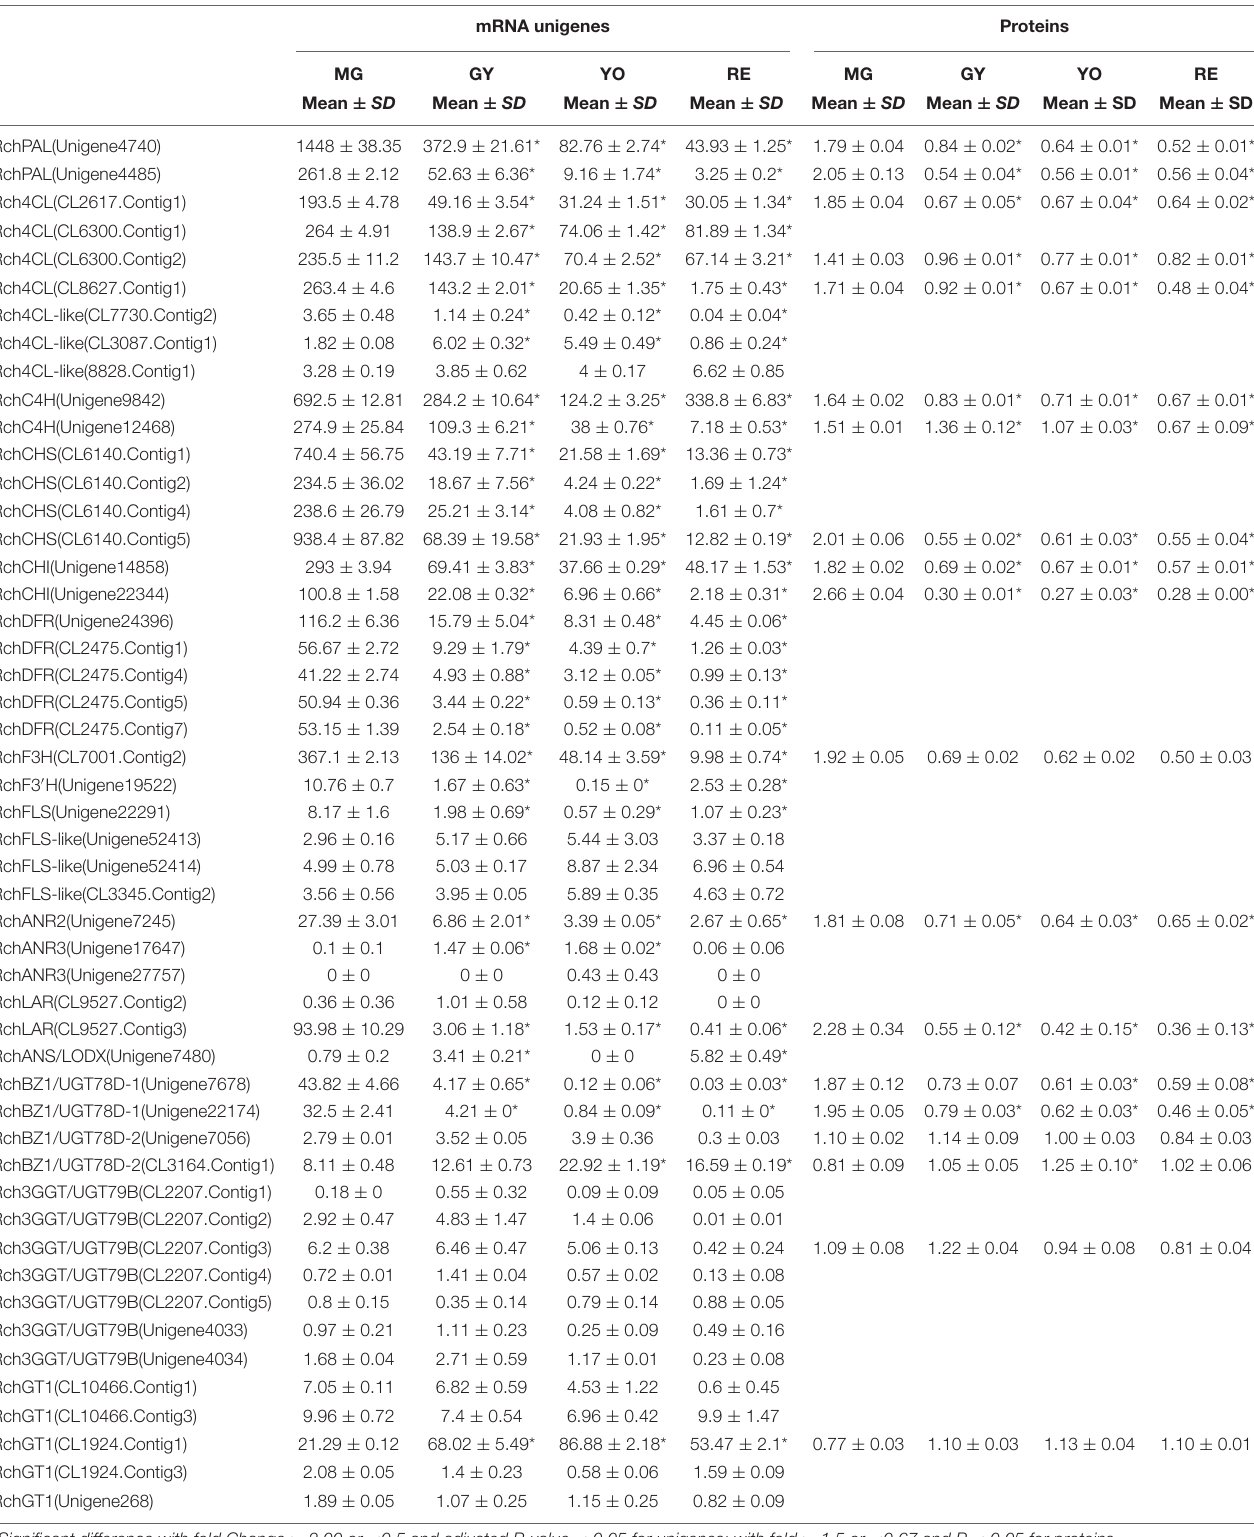
TABLE 2 | The temporal change in expression of mRNA unigenes an proteins involved in phenylpropanoid, flavonoid, and anthocyanin biosynthesis during four maturation phases in Rubus chingii Hu. mRNA unigenes